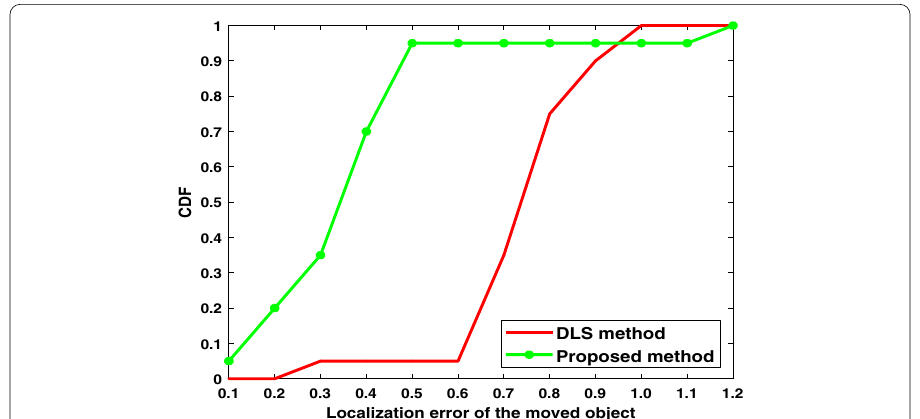
Fig. 13 Localization error CDF comparison of the displaced object when the simulation is running by real data